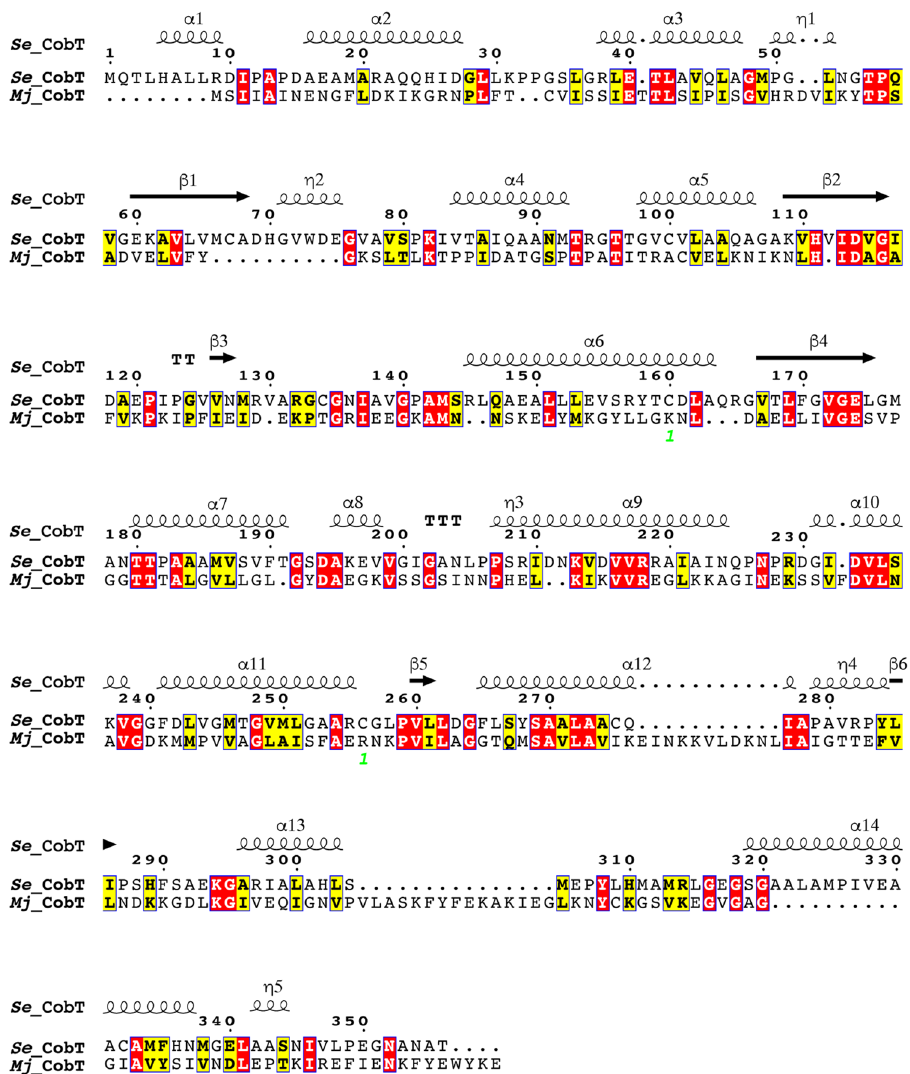
Figure 7. Comparison of the Mj CobT and Se CobT primary sequences. This alignment was constructed using the online ESPrit 3 algorithm 27